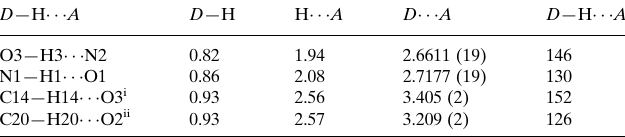
Hydrogen-bond geometry (A˚ , (cid:2)